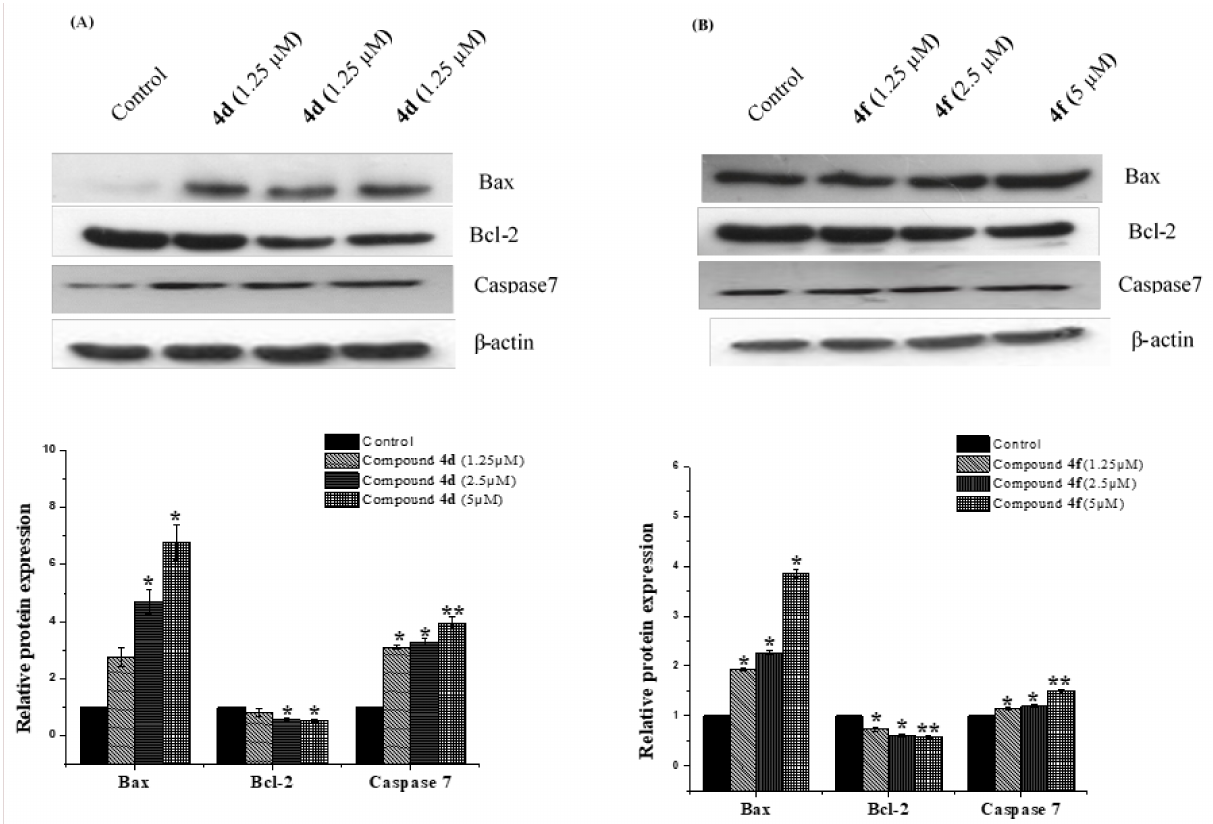
Figure 7. Impact of compounds 4d and 4f at various on the expression of apoptosis related genes. MCF-7 cells were treated with vehicle or indicated concentrations (1.25, 2.5 and 5 µ M), respectively, for 24 h time period. ( A ) After the treatment, Western blot analysis of Bax, Bcl-2 and caspase 7 was performed. Loading was normalized to the levels of β -actin ( B ) Band quantification of target proteins was performed using Image j software. Data shown are means ± SD ( n = 3) (* p < 0.05, ** p <